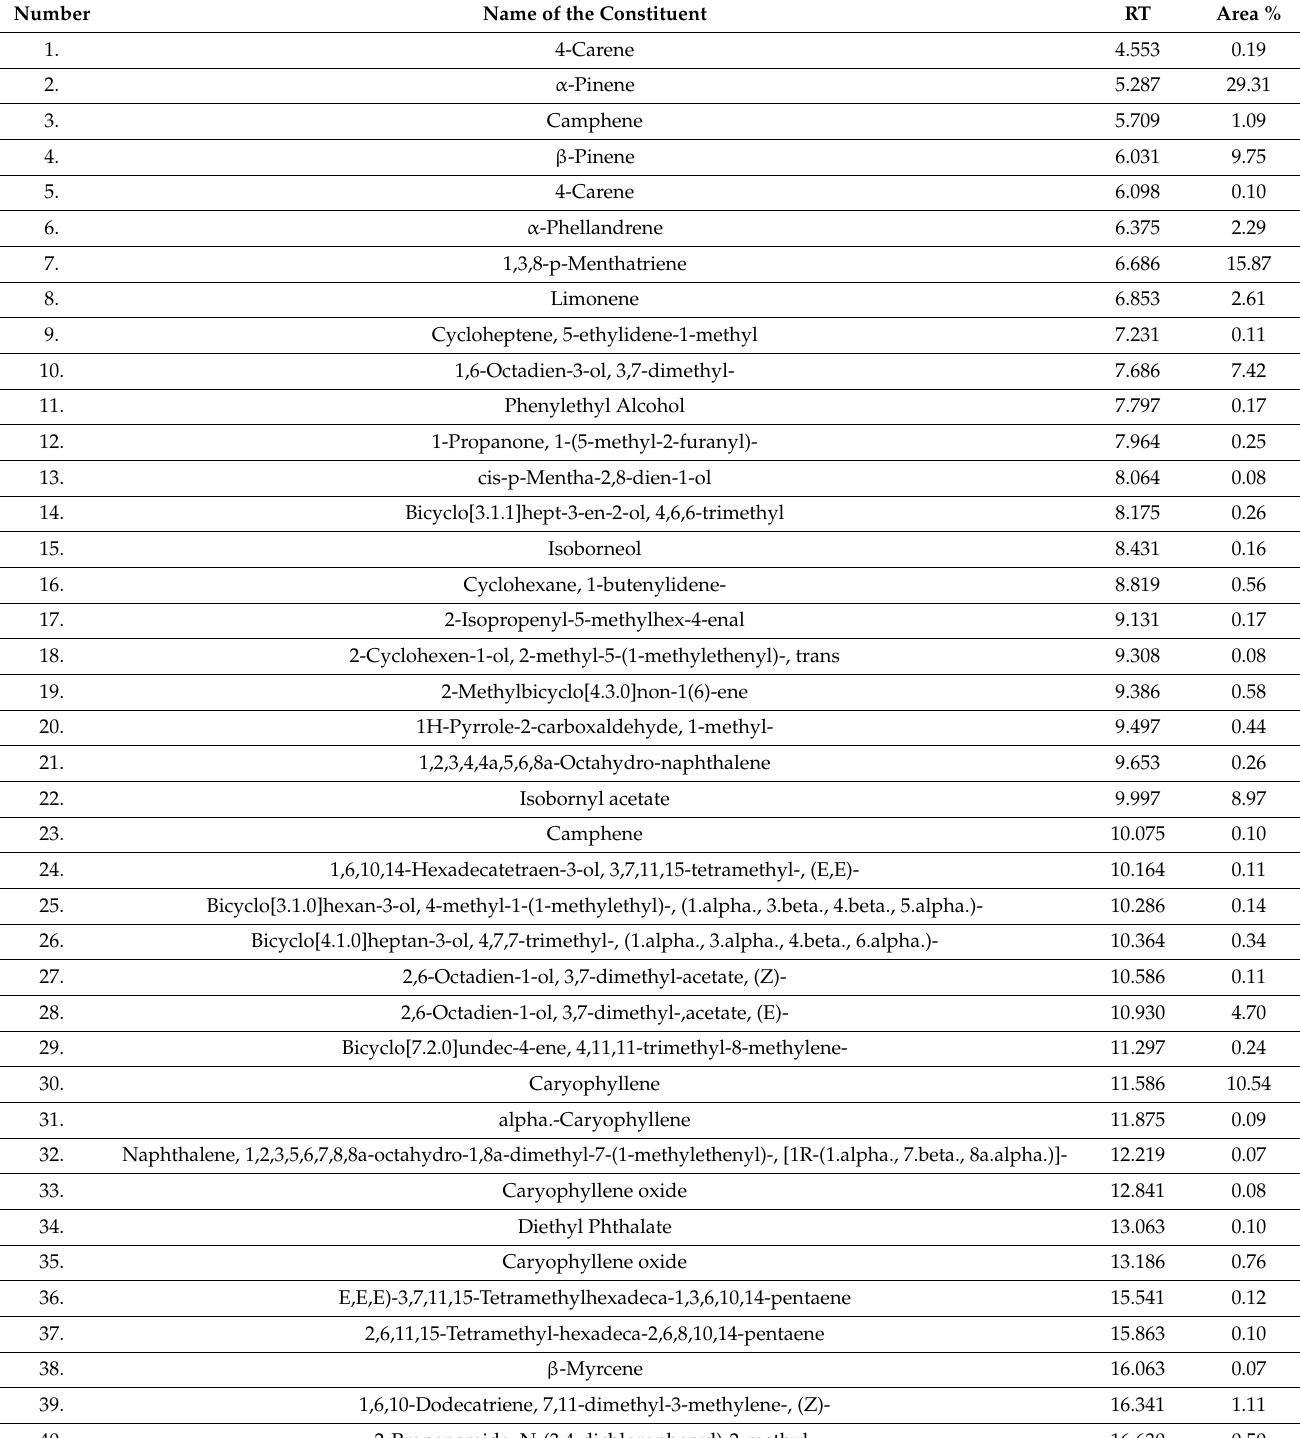
Table 1. List of constituents detected by